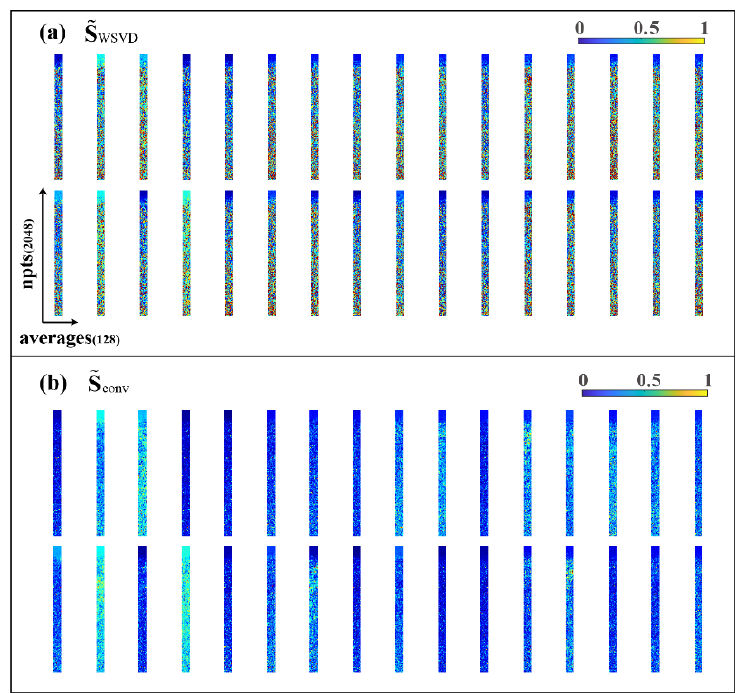
Figure 4. Visualization of 32 coil sensitivity matrices. ( a ) Sensitivity matrix obtained from WSVD; ( b ) sensitivity matrix after convolution smoothing (convolution kernel size k is 7). To obtain a smoother sensitivity matrix, as expected, we introduced SENSE [10], an MRI multicoil-combination method, and did the two-dimensional convolution smoothing ~ S WSVD between each sampling by using average filtering convolution kernels ϕ ( k )